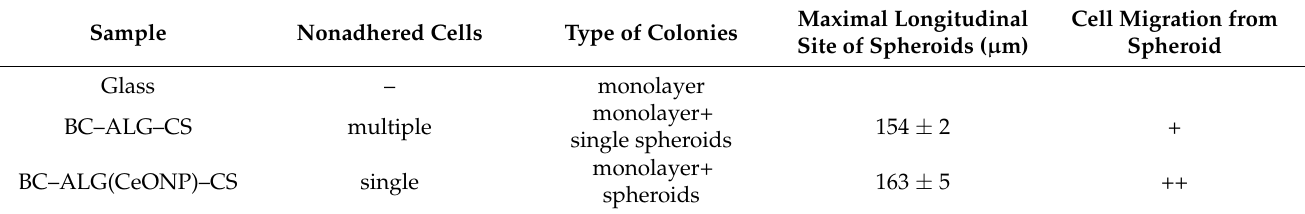
Table 4. Characteristics of multipotent mesenchymal stem cells and cell colonies formed on the surface of the scaffolds on the third day after